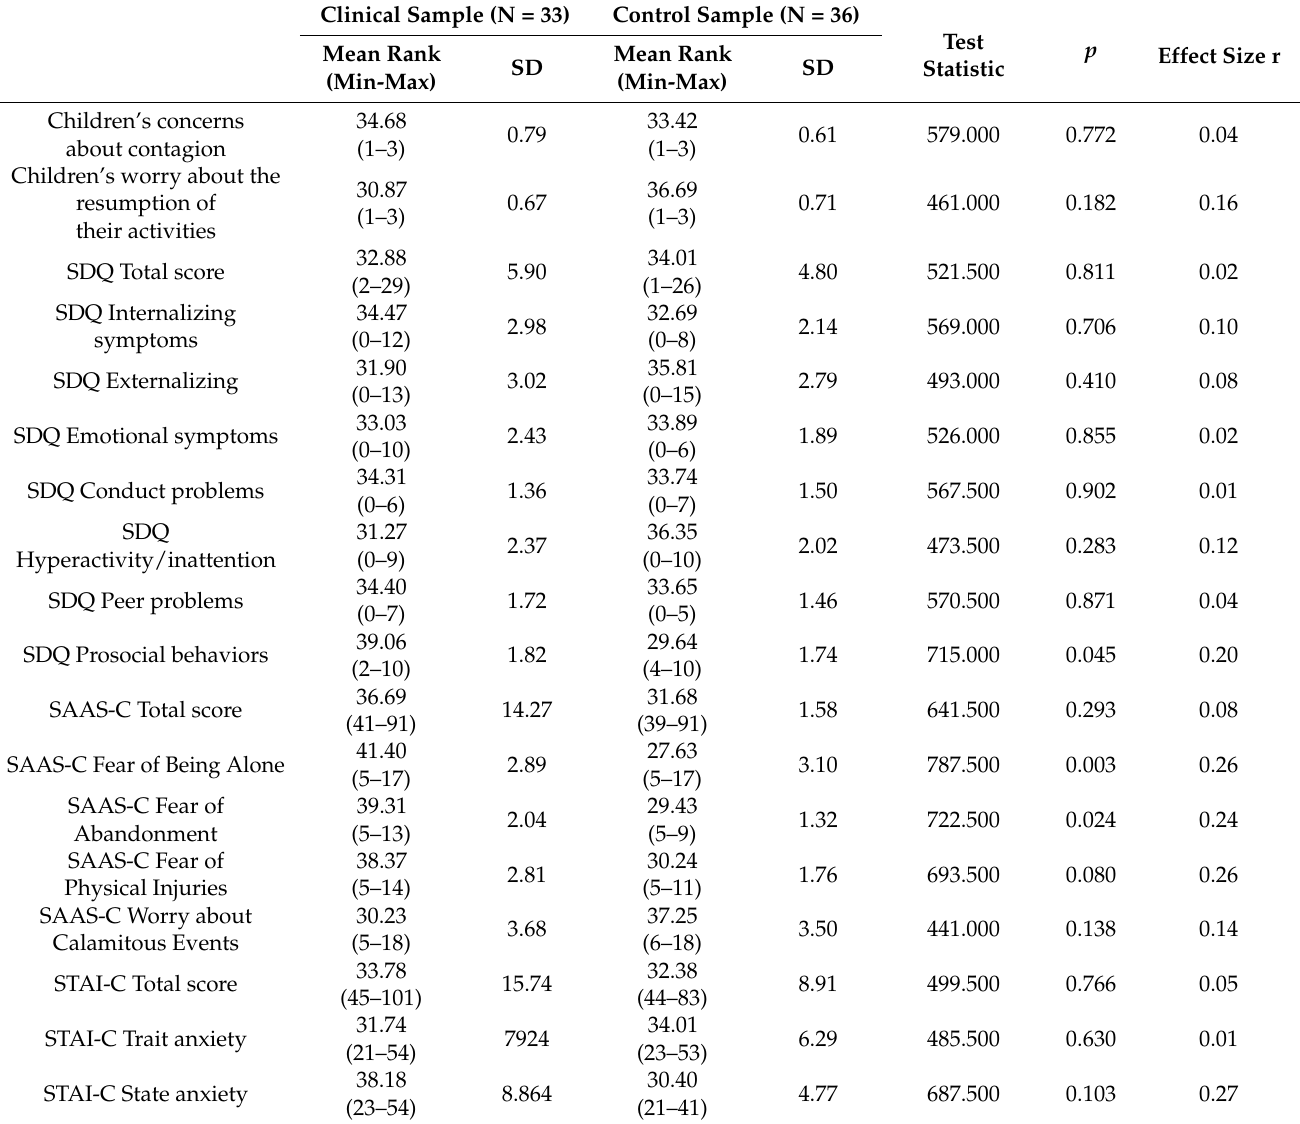
Table 2. Mann–Whitney U tests used to evaluate the differences between children of the clinical and control groups in survey variables and standardized questionnaires. Mean rank, minimum (min) and maximum (max), standard deviations, and test statistics are reported. Effect sizes’ r values: 0.00–0.20 low, 0.20–0.50 medium, 0.50–2.00